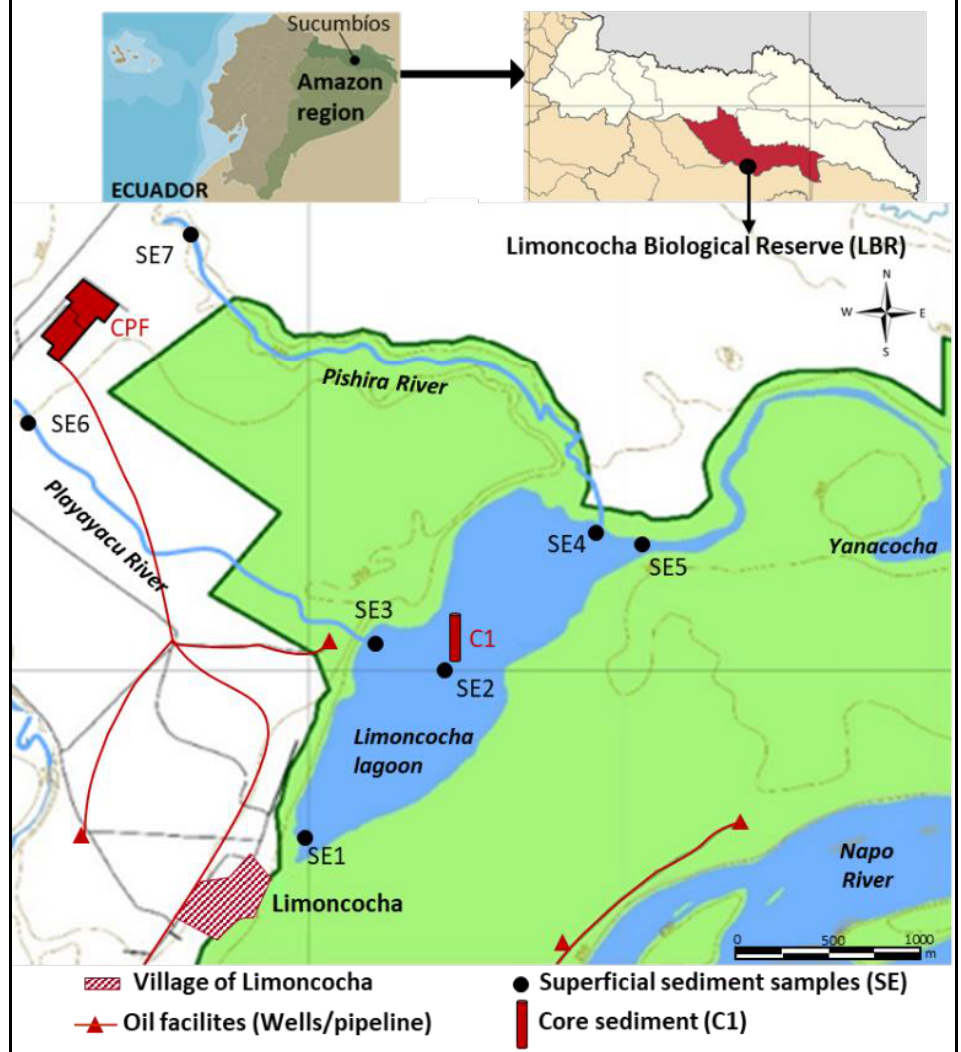
Figure 1. Limoncocha lagoon with the location of the core sediment (C1) and surface sediments